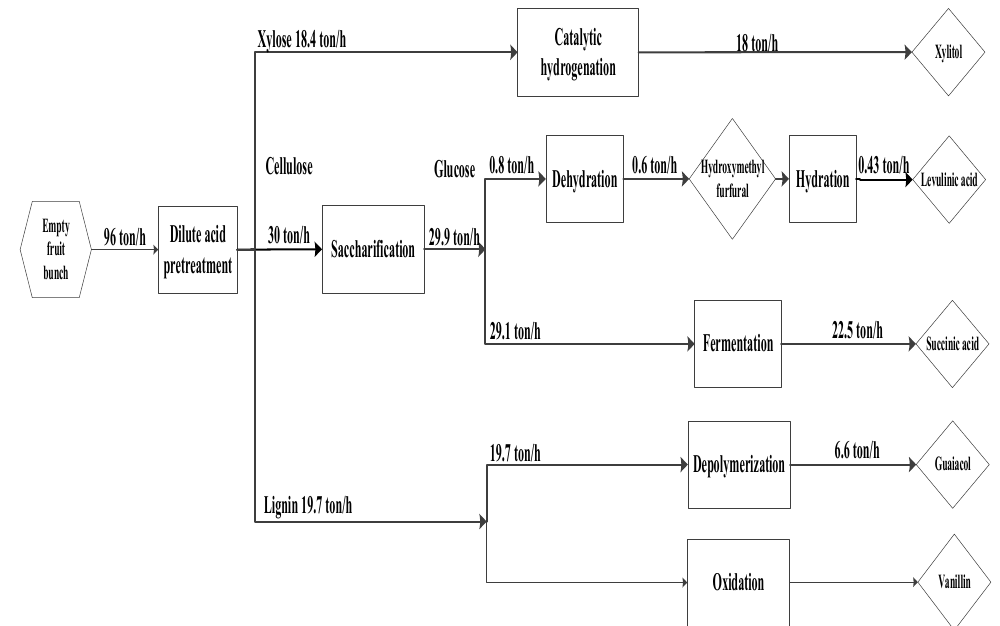
Figure 9. The optimal biorefinery configuration of the optimal point S1 for profit and fire explosion damage index in Figure 8a.